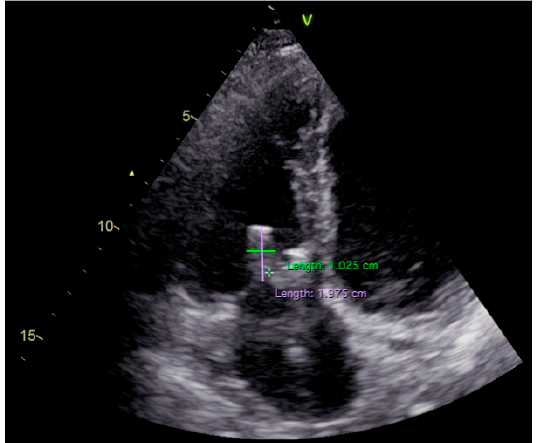
Figure 3. Transthoracic two-dimensional echocardiography apical four-chamber view: large hypoechogenic hyper-pedunculated mobile mass (19,5/10 mm) at the level of tricuspid valve.